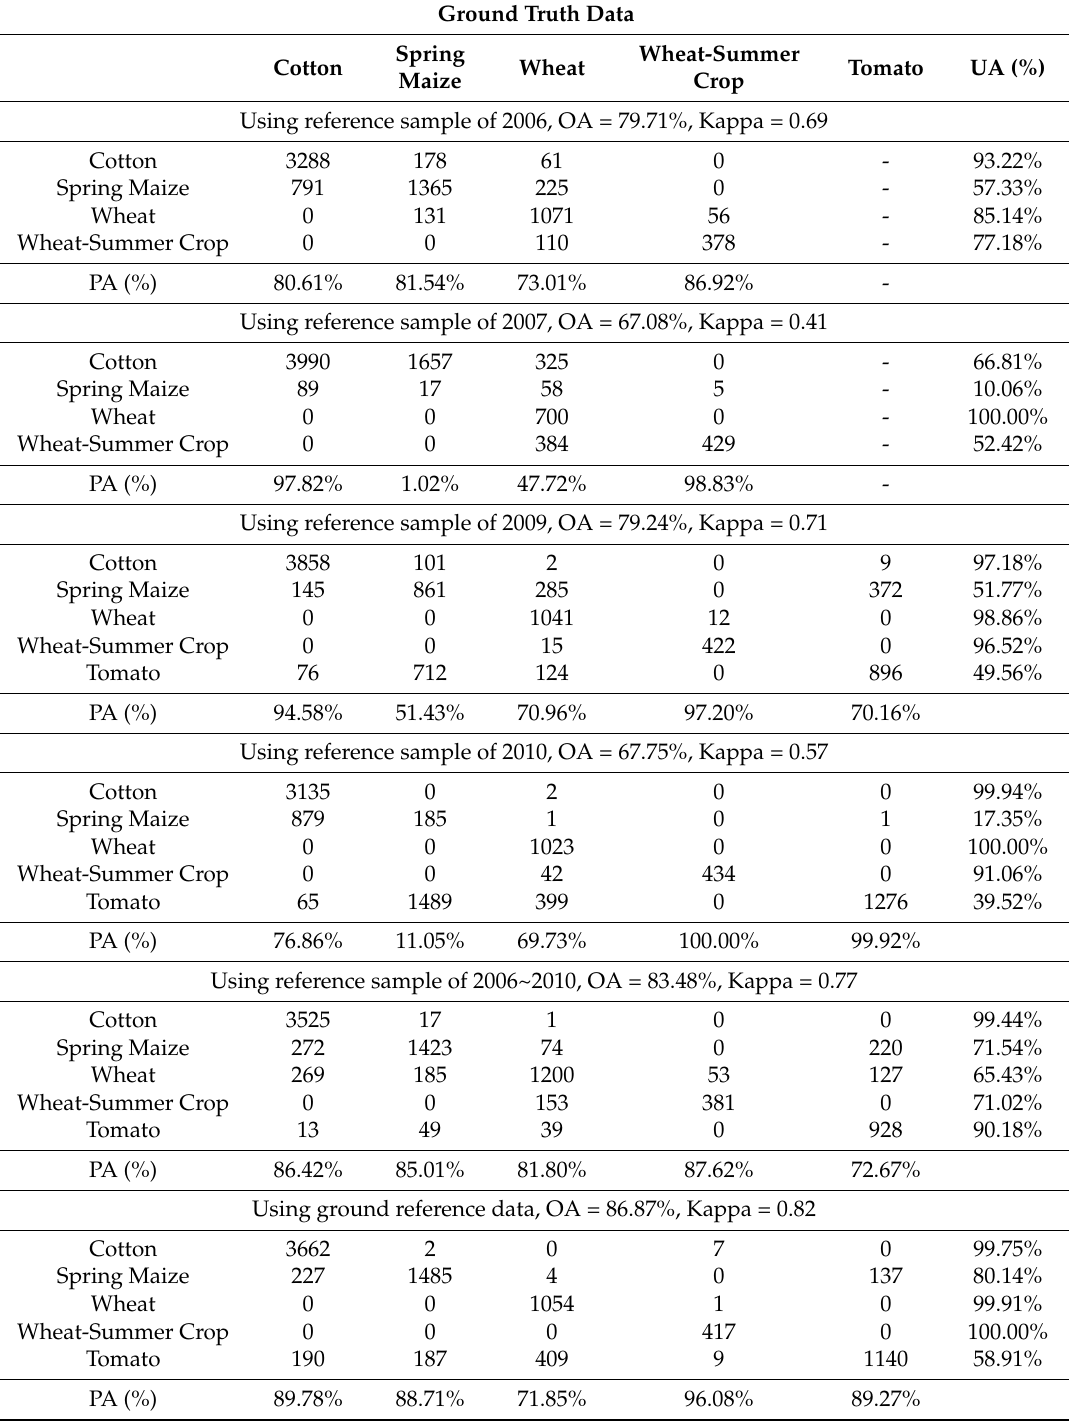
Table 9. Error matrix for